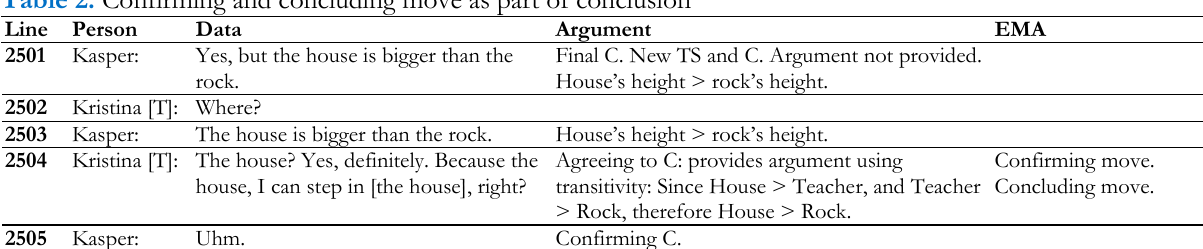
Table 2. Confirming and concluding move as part of